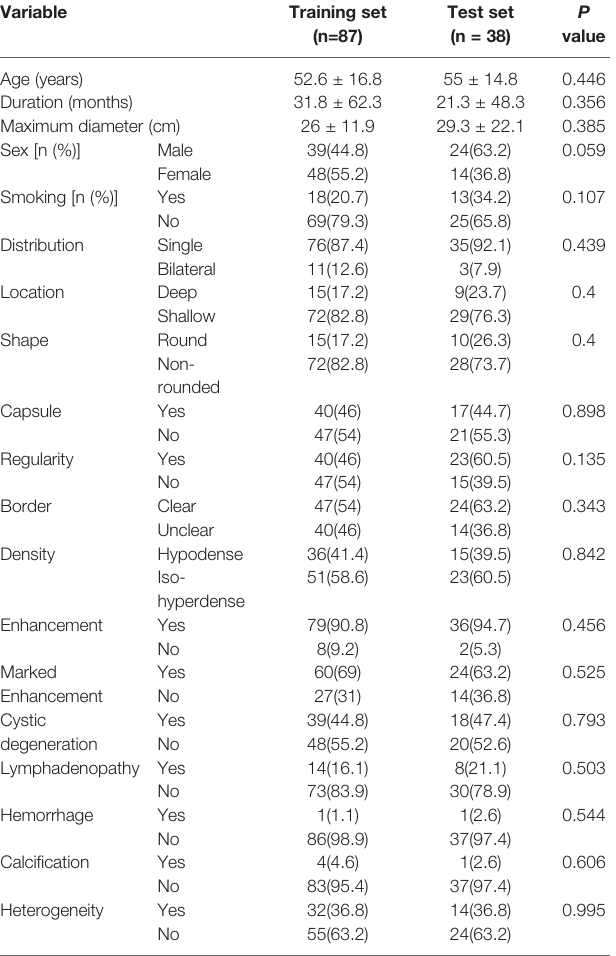
TABLE 2 | Clinical and radiological characteristics of patients in the training and test sets.